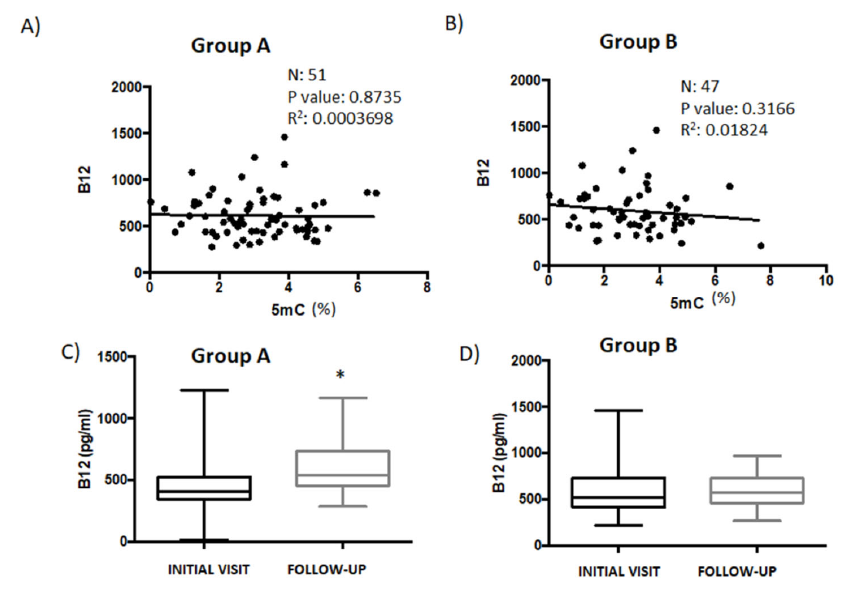
Figure 4. The relationship between vitamin B12 level and global DNA methylation in patient serum samples. ( A ) Correlation analysis to test the association between vitamin B12 and 5mC levels in serum samples from patients in Group A ( n = 51) and ( B ) from patients in Group B ( n = 47). Vitamin B12 levels measured during the initial ‐ and follow ‐ up consults were compared between patients in ( C ) Group A and ( D ) Group B. Data are presented as the mean ± S.E.M; paired t test (* p < 0.05). 5mC, 5 ‐ methylcytosine.